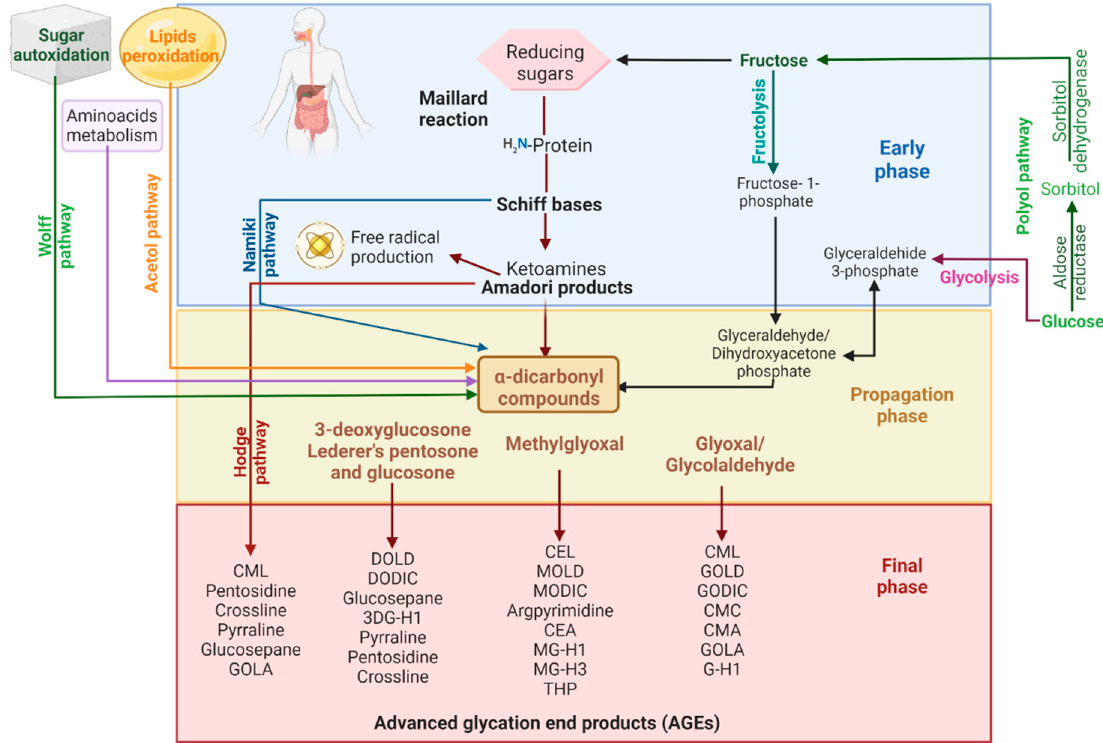
Figure 1. Endogenous AGEs formation in human body. AGEs are typically formed in three phases. The early phase involves the Maillard reaction between sugar and proteins and concludes with the formation of Amadori products. Subsequently, the propagation phase generates α -dicarbonyl compounds such as methylglyoxal, glyoxal, and 3-deoxyglucosone. A great variety of AGEs emerge during the final phase. In addition, other pathways that could exacerbate the quantity of AGEs precursors comprise sugar autoxidation, aminoacids metabolism, lipids peroxidation, polyol pathway, fructolysis, and glycolysis. Created with BioRender.com. Adapted from Zeng et al. [6].